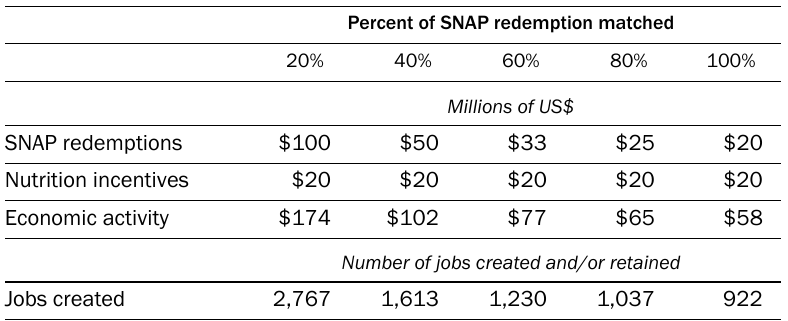
Table 4. Projected Annual Economic Impact of the Food Insecurity and Nutrition Incentive